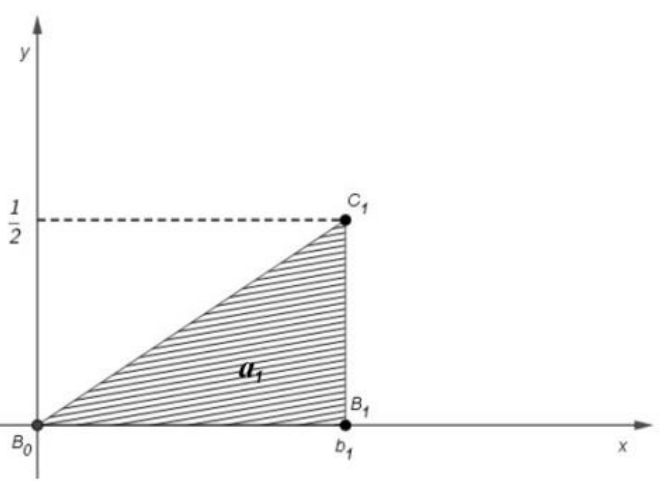
Figure 1. Points 𝐵 0 , 𝐵 1 , 𝐶 1 in the coordinate system.